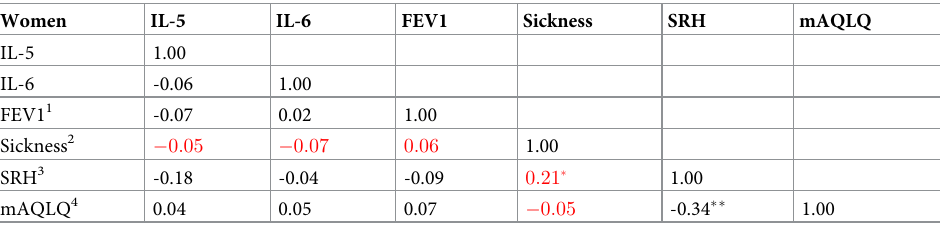
Table 4. Spearman’s correlations for changes in cytokines, FEV1, sickness behaviour, asthma-related quality of life and self-rated health between baseline and follow-up in